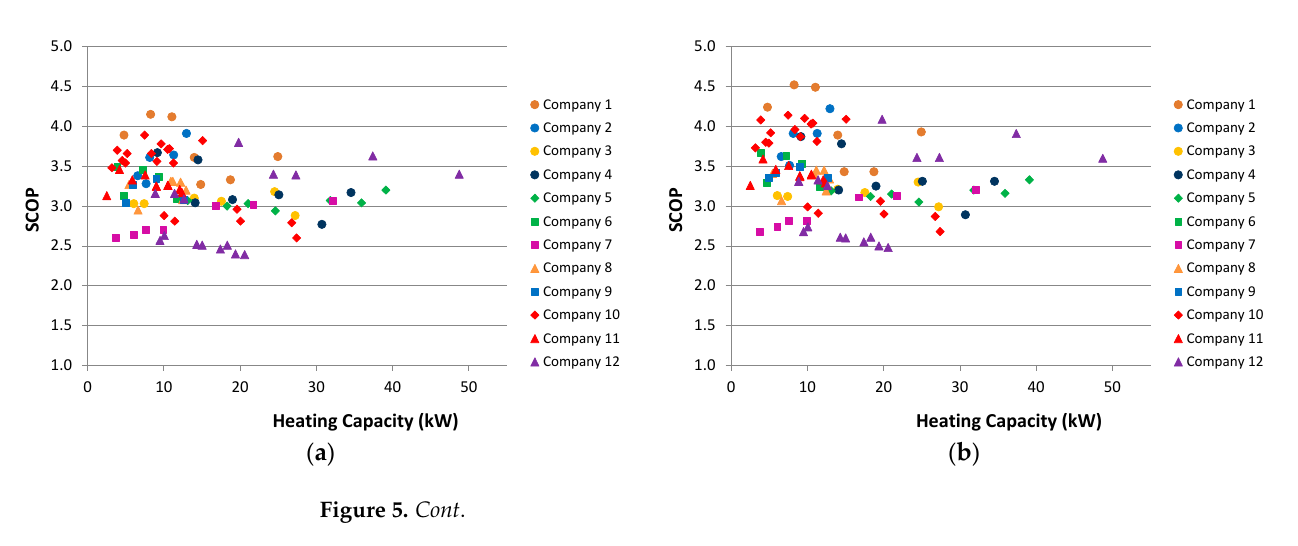
Figure 4. SCOP against HP’s heating capacity for the city of Athens: ( a ) Τ w,outlet = 35 °C — without compensation, ( b ) Τ w,outlet = 35 °C — with compensation, ( c ) Τ w,outlet = 45 °C — without compensation, ( d ) Τ w, outlet = 45 °C — with compensation, ( e ) Τ w,outlet = 55 °C — without compensation, ( f ) Τ w,outlet = 55 °C — with compensation.